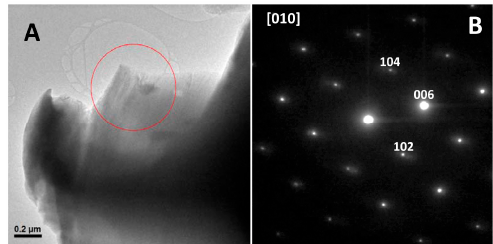
Figure 7. Representative ( A ) Transmission electron microscopy (TEM) image and the corresponding ( B ) Selected area electron diffraction (SAED) pattern from the marked area of the crystal along the [010] projection of the powder calcium carbonate precipitates obtained in the presence of Gad m 1 wt and mutant amyloids.